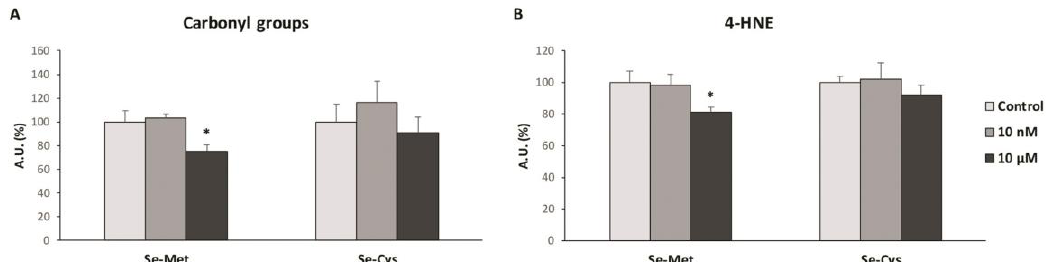
Figure 4. Protein and lipid oxidative damage in MCF-7 breast cancer cell lines after treatment with selenoamino acids at 10 nM and 10 μM. The cells were treated with vehicle (clear grey bars), selenoamino acid at 10 nM (dark grey bars) or selenoamino acid at 10 μM (black bars) for 48h. ( A ) Protein carbonyl groups formation. ( B ) 4-Hydroxy-2Nonenal adducts formation (4-HNE). Bars represent means and error bars represent SEM ( n = 6). The value of control cells was set at 100% and the rest of values were calculated referenced to the control set at 100%. * Significant differences between selenoamino acid treated and control cells (Student’s t-test; p ≤ 0.05). AU: Arbitrary Units.